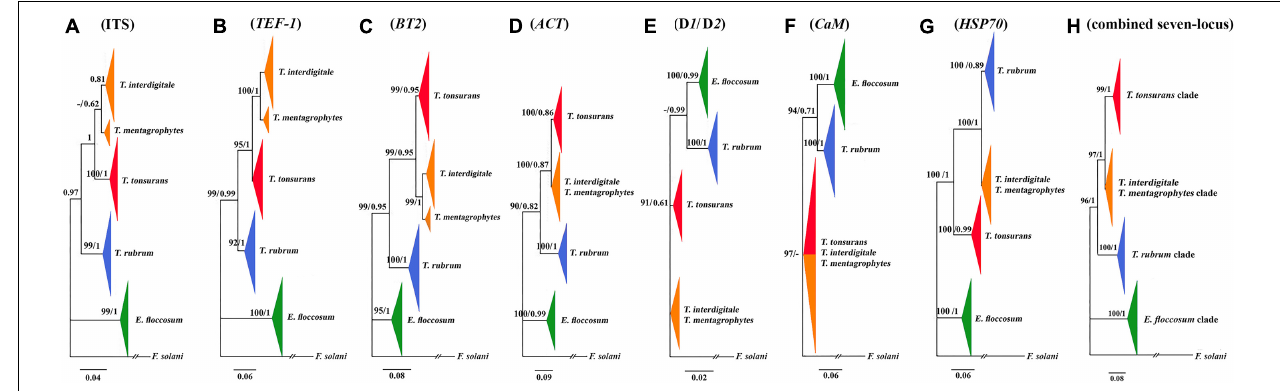
FIGURE 1 | Comparison of seven trees constructed by the Bayesian analysis. Phylogenetic analysis of ITS (A) , TEF-1 α (B) , BT2 (C) , ACT (D) , D1/D2 (E) , CaM (F) , HSP70 (G) , and the consensus trees constructed by the Bayesian analysis from the combined seven-locus (H) of the 95 clinical isolates, four reference strains, and use of F. solani as the outgroup. The bootstrap percentages of the ML analysis and posterior probabilities values are presented at the node (PP/BS). Values less than 70% bootstrap support in the ML analysis and less than 0.5 posterior possibility in the Bayesian analysis were indicated with a hyphen.